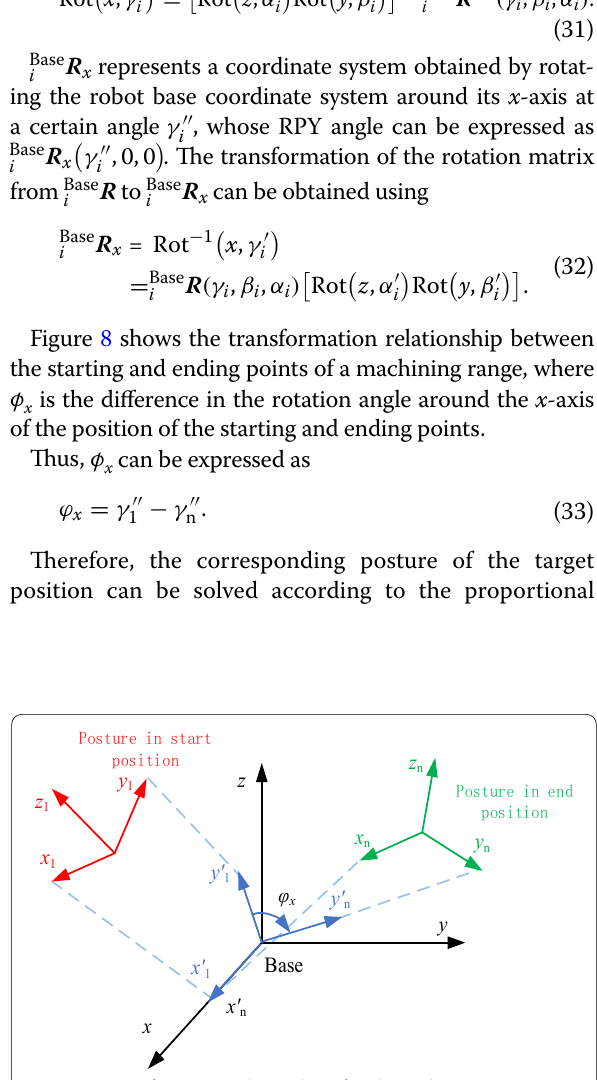
Figure 8 Transformation relationship of endpoint